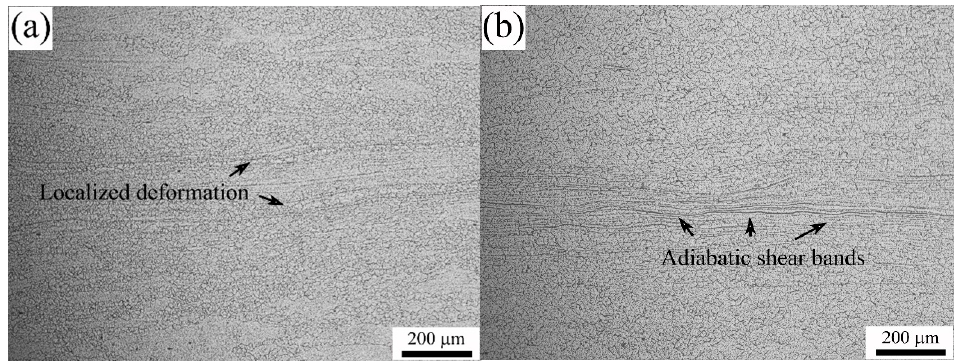
Figure 17. Typical instable microstructures of 70MnSiCrMo carbide-free bainitic steel: ( a ) 1273 K/5 s − 1 ; ( b ) 1423 K/5 s − 1 .